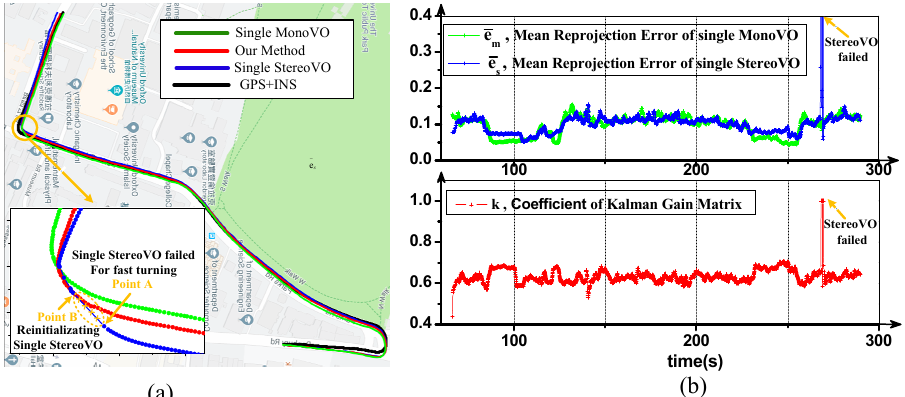
Figure 9. ( a ) shows that four trajectories, including single MonoVO, single StereoVO, GPS+INS and our method. Single StereoVO fails at point A because of the fast change of scenes and reinitializes at the point B. ( b ) shows the mean reprojection error ( e k ∈{ s , m } ) of two visual odometry systems and the coefficient of Kalman gain matrix. The failing of Single StereoVO leads to the abrupt change of blue trajectory at the 289 s. For the coefficient k, it is equal to 1, which means that the system only utilizes the information only from single monocular visual